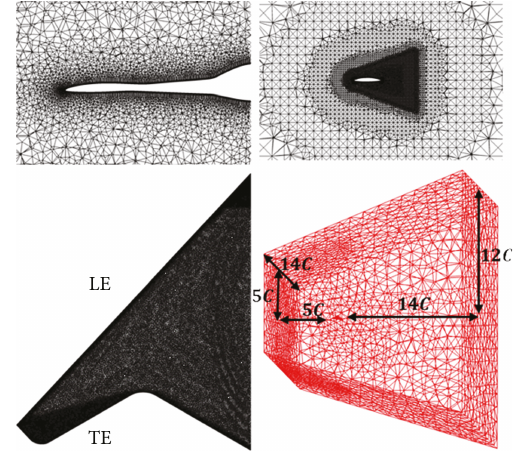
Figure 3: Computational domain and grid details.